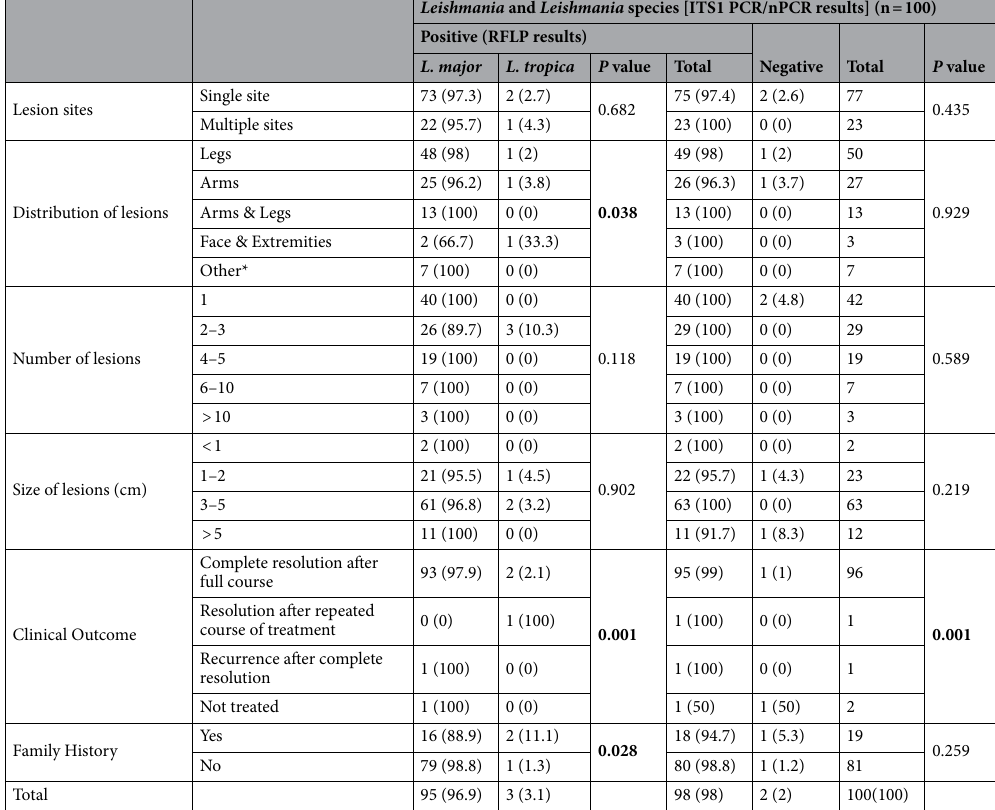
Table 6. Clinical data of the study individuals in association with Leishmania [ITS1 PCR/nPCR results] and Leishmania species [ITS1 PCR/nPCR-RFLP results]. *Other: Sites include abdomen, chest, shoulder, and buttock. Significant values are in